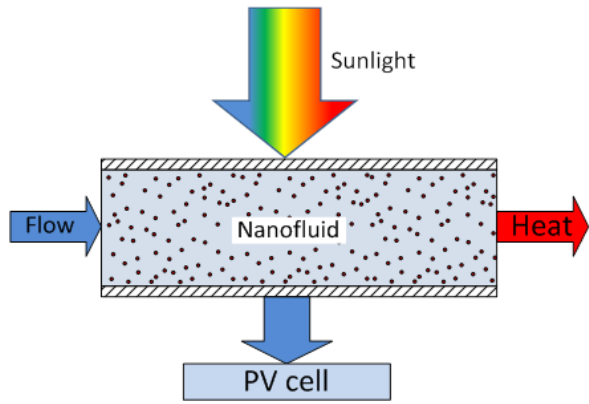
Figure 7: Nanofluid-based spectral beam splitting in hybrid PV-T